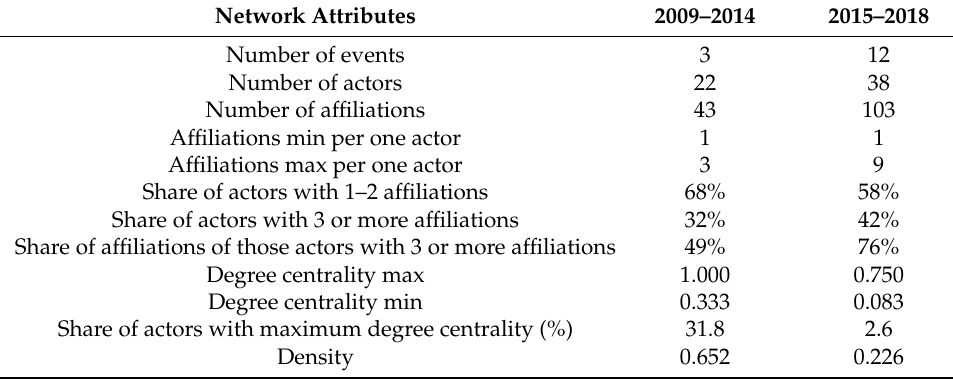
Table 1. Network